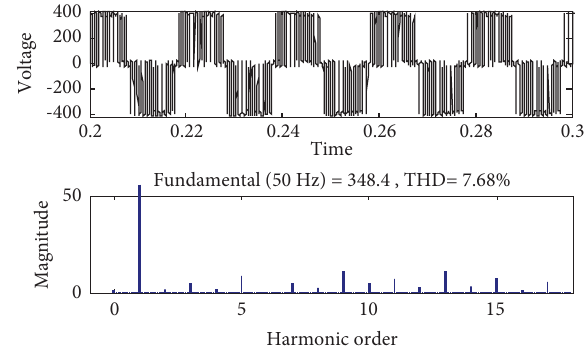
Figure 14: Output voltage and THD analysis with MHPSO